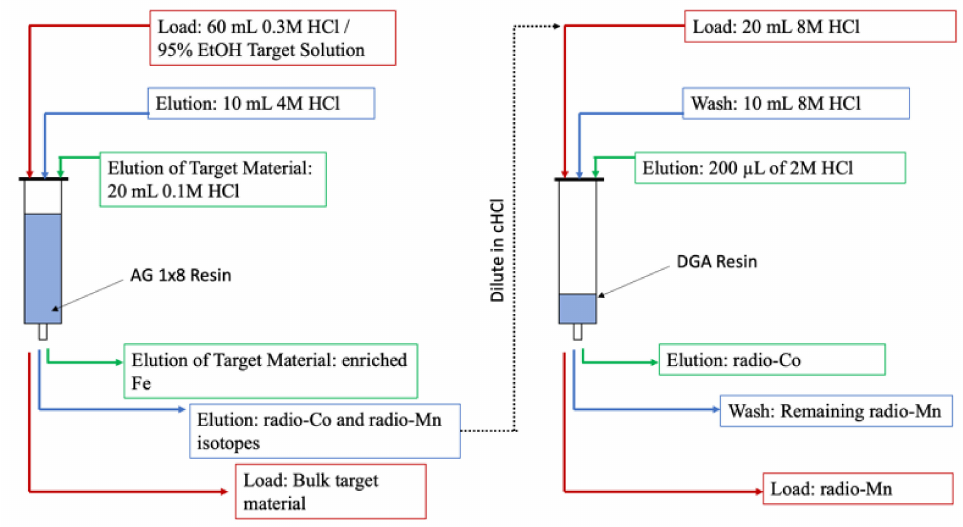
Figure 18. Flow diagram of the two-column method for the separation of cobalt-5x from